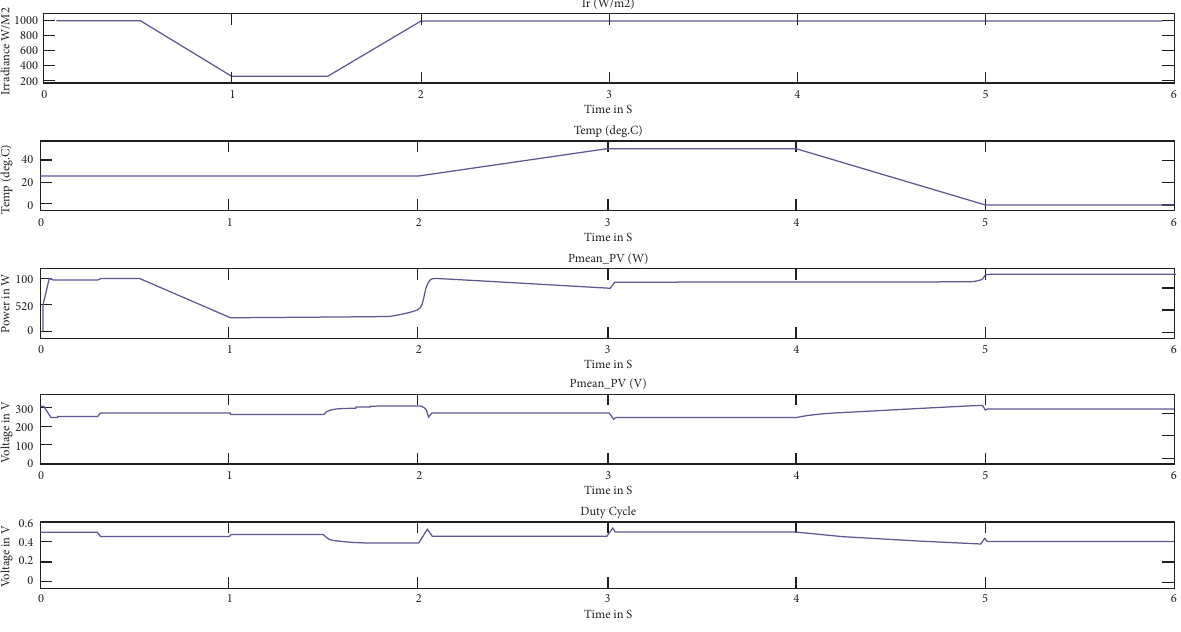
Figure 10: Output graphs of the proposed P and O